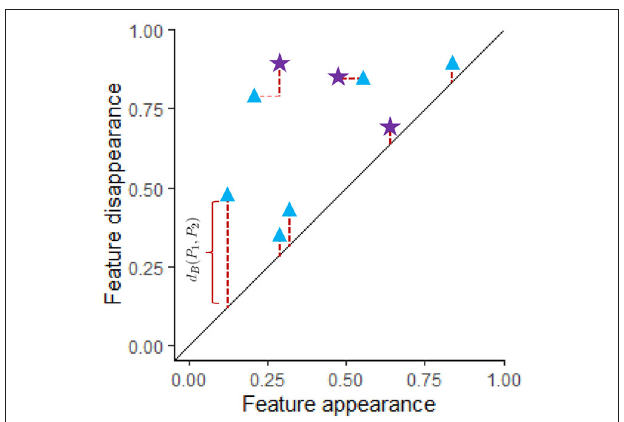
FIGURE 4 | Two persistence diagram, P 1 and P 2 , are shown for a single dimension (for example, β 1 ). The blue triangles correspond to P 1 while purple stars are used for P 2 . Both persistence diagrams include the diagonal. A matching between P 1 and P 2 is shown where the red dotted lines indicate features that have been matched where some of the features are matched to the diagonal. The length of the thicker dark red dotted lines indicate the distance between matched features. The distance between a feature and the diagonal is the persistence of the feature, d − b , where b = birth time and d = death time of that feature. If feature ( b , d ) is matched with feature ( β , δ ), then the distance between these features is max( | b − β | , | d − δ | ). Since the best matching is shown, d B ( P 1 , P 2 ) equals the length of the longest of the thick dark red dotted lines. Any other matching would have a matched pair of features with larger